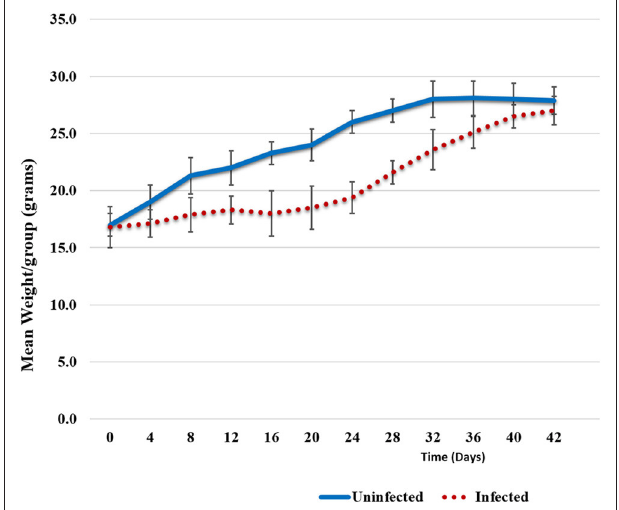
FIGURE 1 | Weight trends . Weight trend graphs show mean weight loss in Chlamydia infected animals vs. uninfected animals. The loss can be seen between days 6 and 32 post-infection; on average 5.7g smaller (30%). However, infected mice recovered lost weight by day 42. Error bars represent variation from the mean weight within each